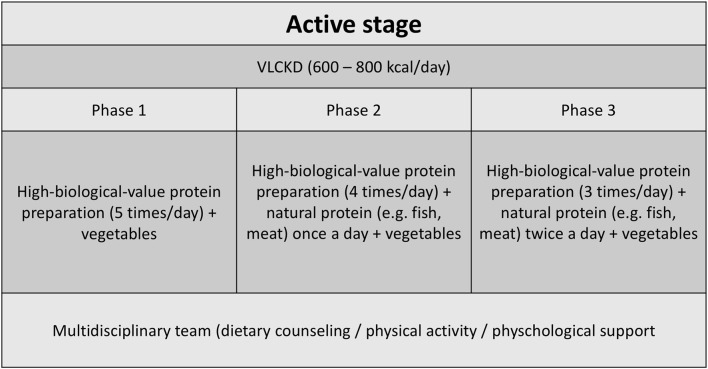
Active phase dietary counseling for patients undergoing the VLCKD method.